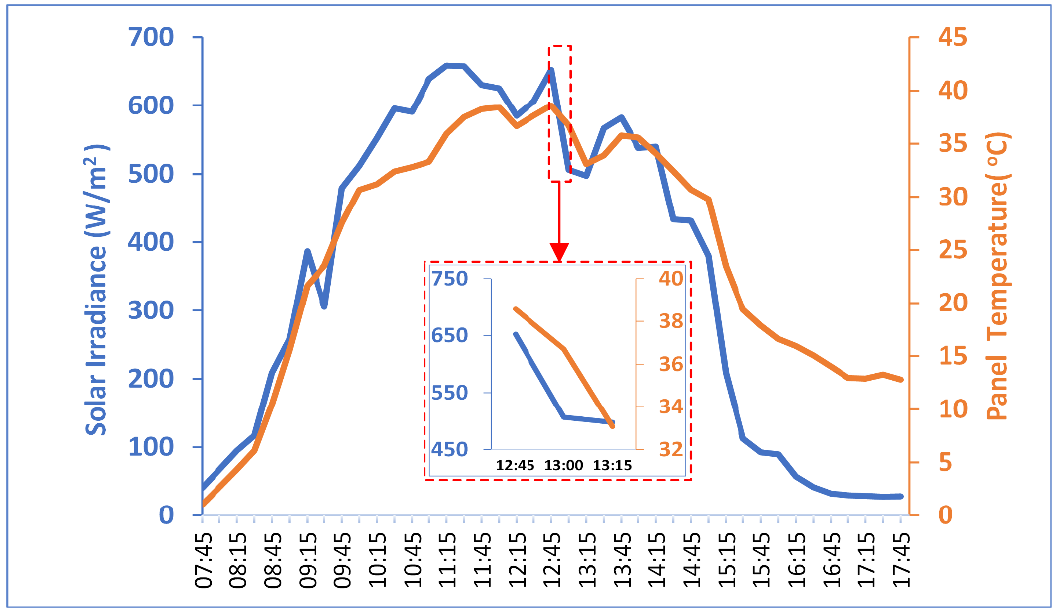
Figure 15. The actual solar irradiance and panel temperature values.